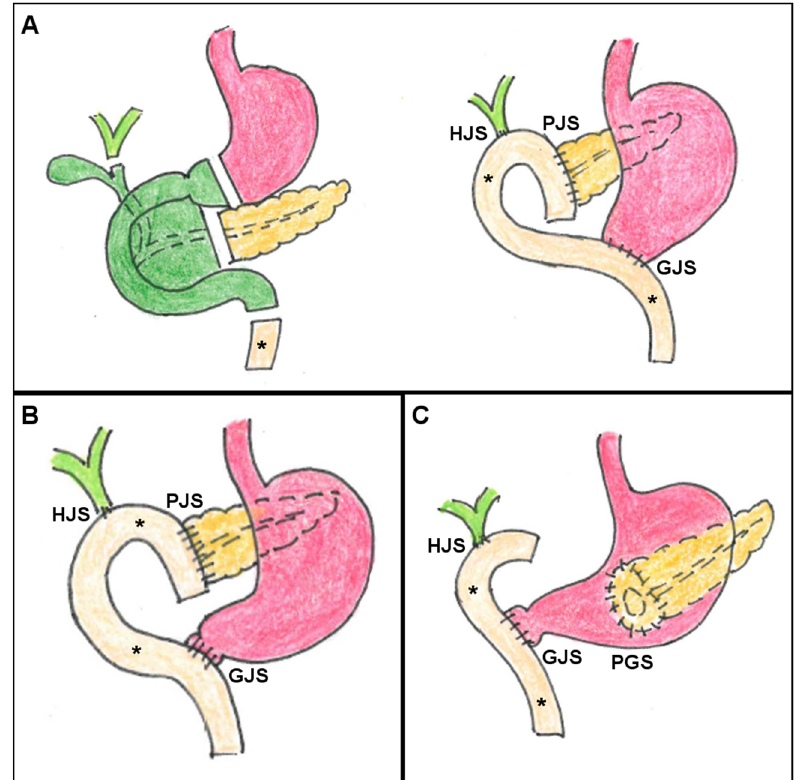
of postsurgical anatomy after classic Whipple ( a ), pylorus- preserving ( b ) and variant ( c ) pancreatico-duodenectomy (PD). The resected pancreatic head and neck, duodenum, choledochus and gallbladder are shown in green ( a ). The stomach is shown in magenta , the pancreatic remnant (PR) body and tail in yellow , the common hepatic duct and main intrahepatic branches in pale green . Asterisk indicates the mobilised jejunal loop (MJL). Note hepatico-jejunostomy ( HJS ), pancreatico-jejunostomy ( PJS ), gastro-jejunostomy ( GJS ), duodeno-jejunostomy (DJS) and pancreatico-gastrostomy ( PGS